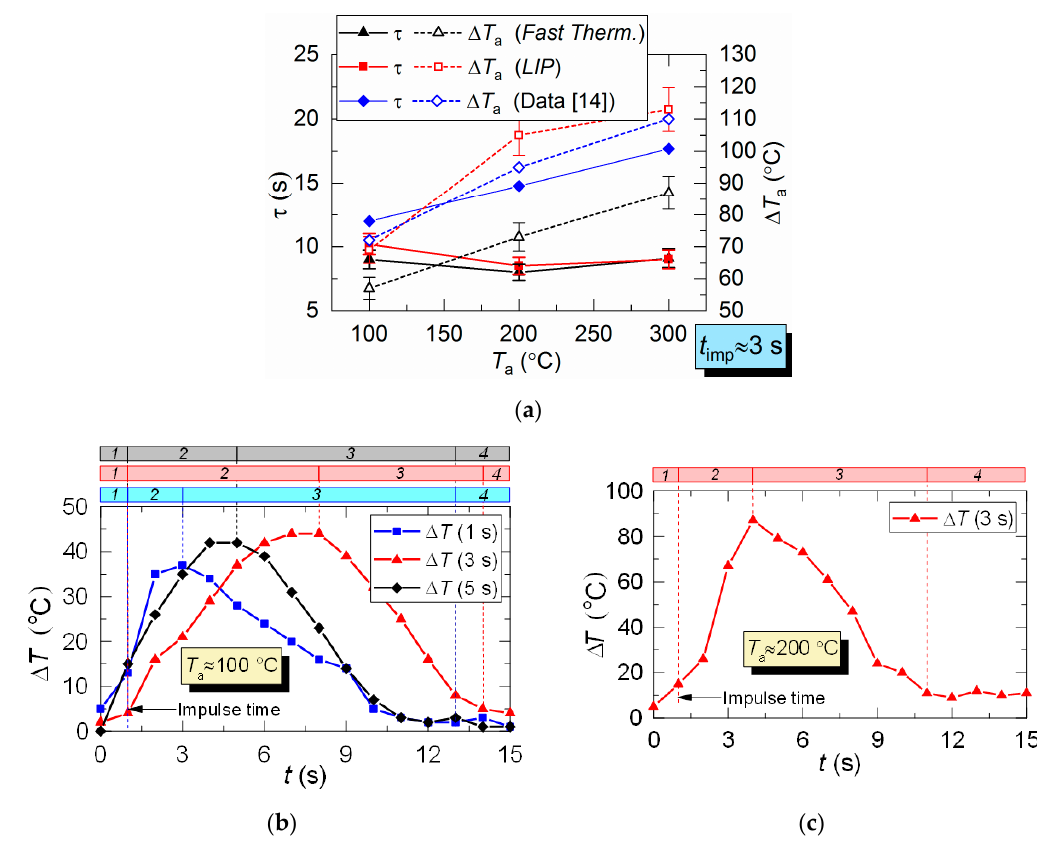
Figure 9. Parameters τ and Δ T a for combustion products flow obtained by two measurement techniques ( a ), as well as difference ( Δ T ) between LIP measurement and fast thermocouple measurement: ( b ) T a ≈ 100 °C; ( c ) T a ≈ 200 °C ( 1 : prior to droplet injection; 2 : T a temperature drop to the lowest value; 3 : T a temperature growth; 4 : T a temperature recovery).